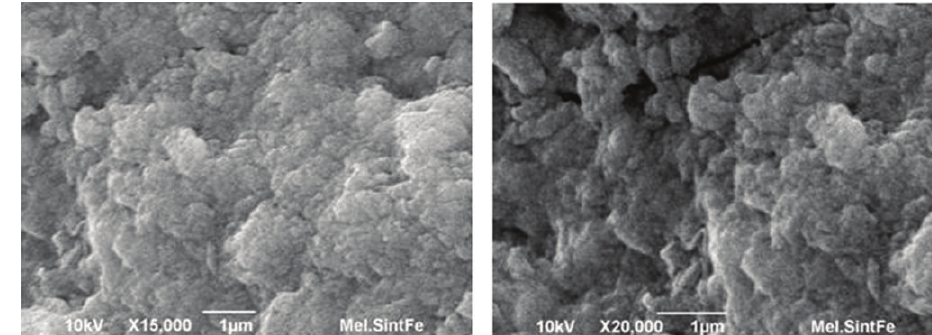
Figure 10: SEM images of the synthetic melanin complex with Fe(III).